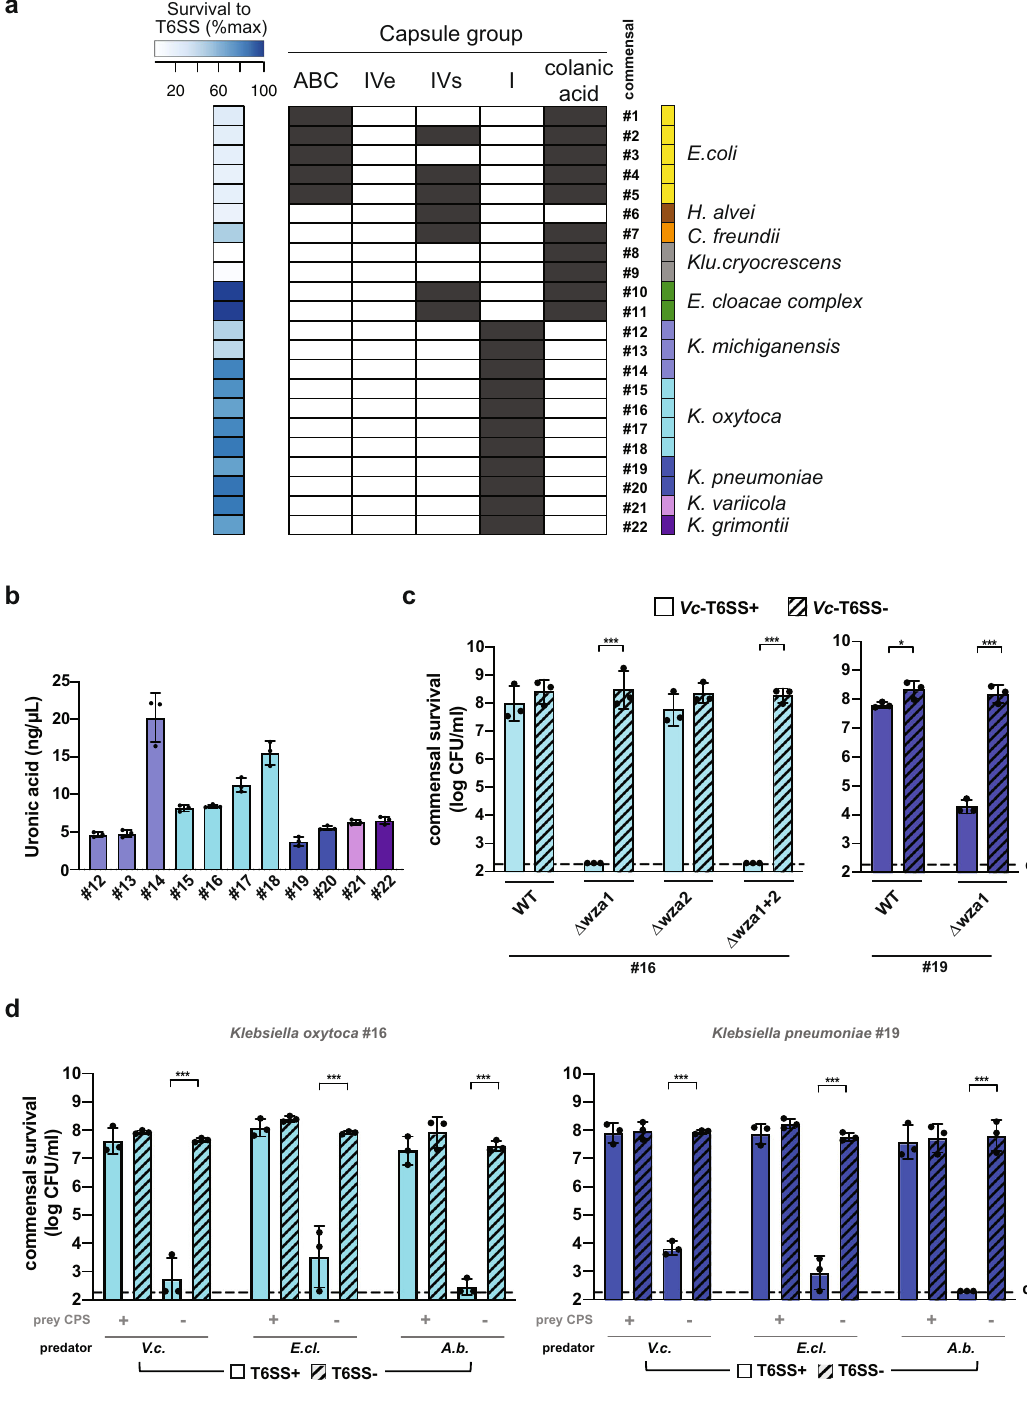
uniquely associated with the group I capsule-speci fi c wza gene product, we generated single and double deletion strains of the respective wza copies. The uronic acid content decreased (Fig. S8a) in those wza mutants that lacked the wza gene located within the capsular gene cluster (Fig. S8b) and microscopy of the bacteria stained using Indian ink revealed that these mutants lost their cell-surrounding CPS material (Fig. S8c). Importantly, these wza mutants (CPS − ) showed a strong sensitivity to T6SS attacks by V. cholerae , while their CPS + parental strains (WT) mostly resisted against the T6SS assaults (Fig. 4c and Fig. S9a), as did